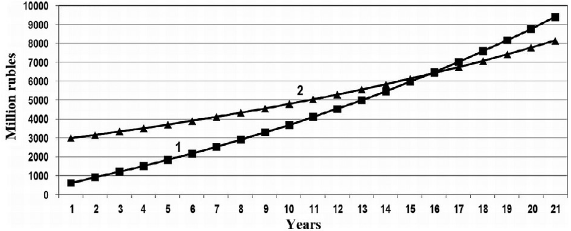
Figure 1. Accumulated integral costs for years of operation of megawatt-class power plants in the Arctic: 1 – 1-MW diesel electric power plant; 2 – 1-MW nuclear power plant.